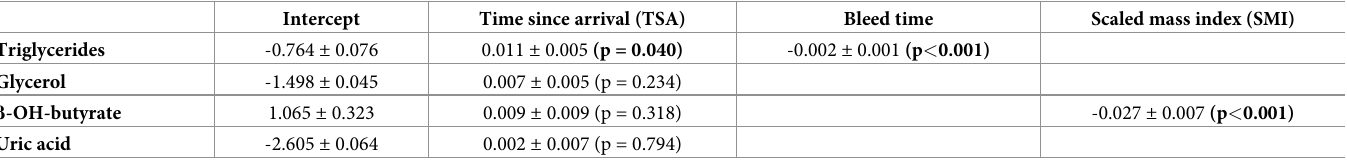
Table 4. Results of the minimum adequate model derived by comparison of nested generalized linear models explaining the relationships between plasma metabo- lite concentrations and time since arrival (TSA) of migrant dunlins in